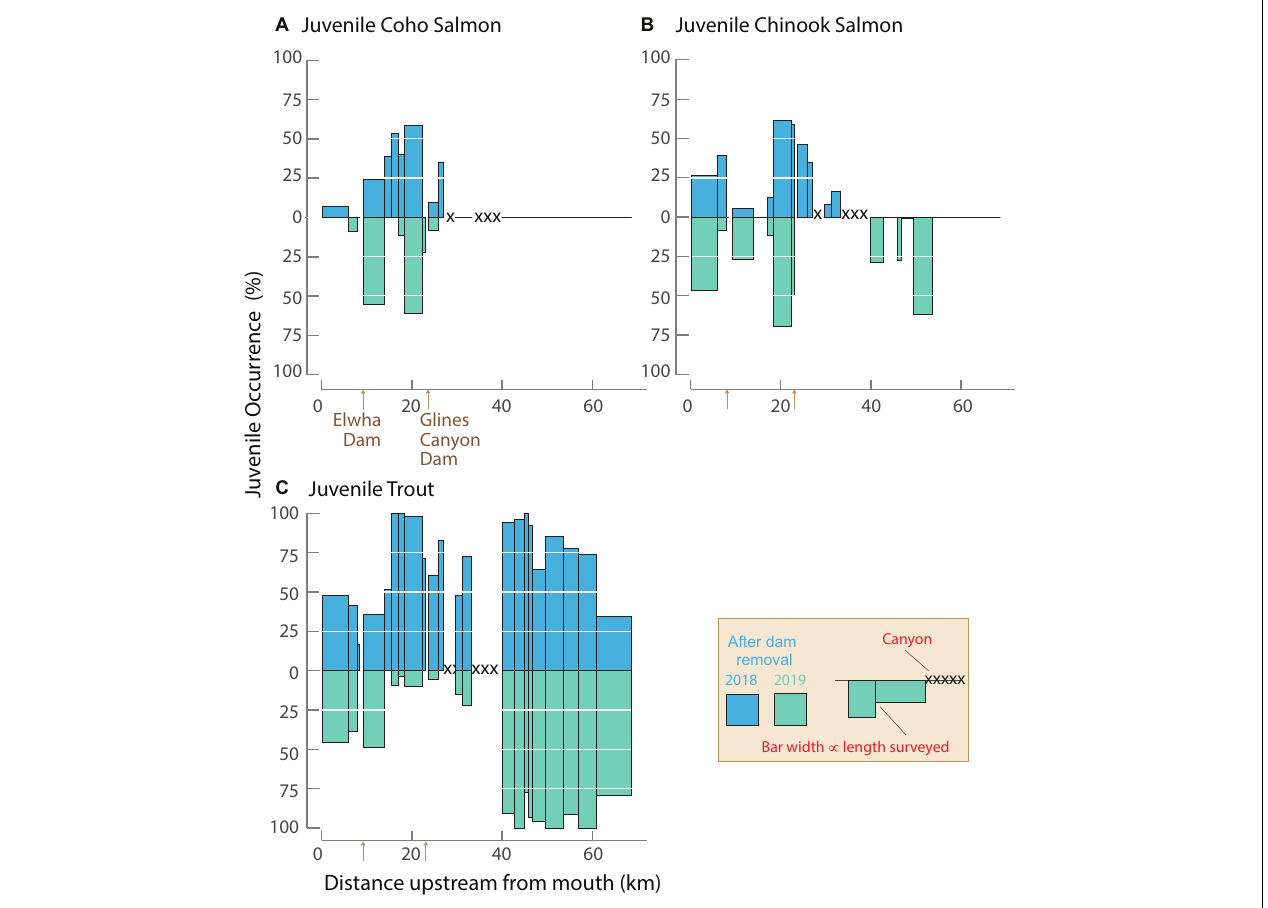
FIGURE 5 | Percentage occurrence of juvenile Coho Salmon (A) , Chinook Salmon (B) , and trout ( C ; potentially includes Rainbow Trout, Steelhead, and Coastal Cutthroat Trout) in riverscape survey reaches. Percentages of reaches occupied by juvenile salmonids are based on channel unit length. Juvenile surveys were not consistently conducted in 2007 and 2008 before dam removal period and are not shown. Unsurveyed canyon sections are indicated with